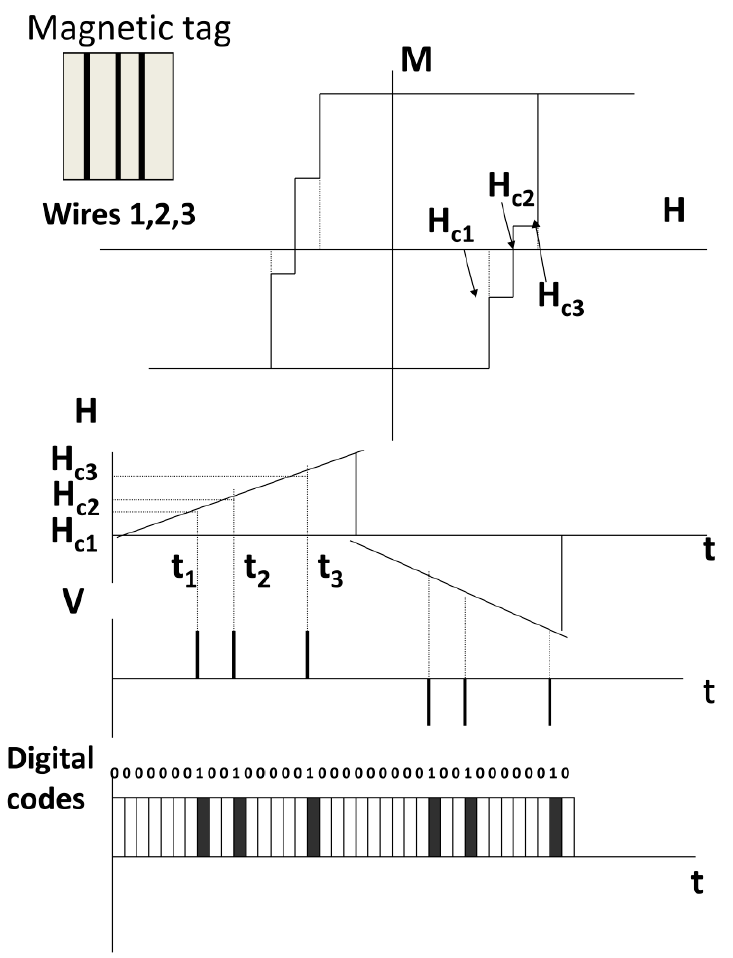
Figure 10. Schematic representation of the encoding system based on magnetic bistability of the microwires. Reprinted with permission from [56].